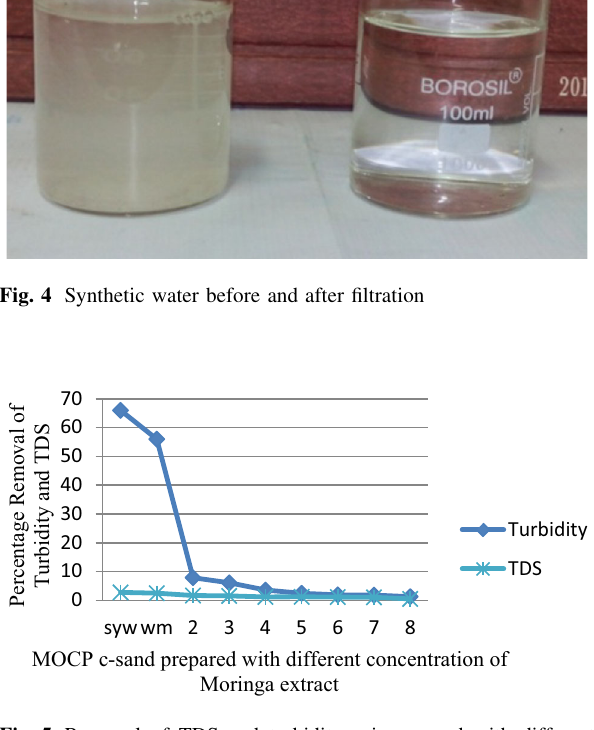
Fig. 5 Removal of TDS and turbidity using c-sand with different concentrations of Moringa